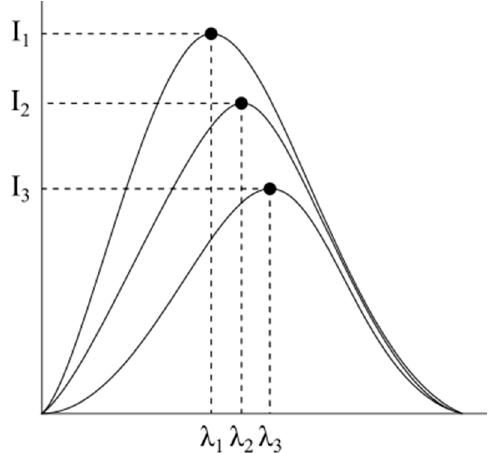
Figure 18. Schematic of near IR luminescence spectra of PbSe QDs showing peak wavelength and intensity trends: peak wavelengths λ 1 < λ 2 < λ 3 , peak intensities I 1 > I 2 > I 3 .